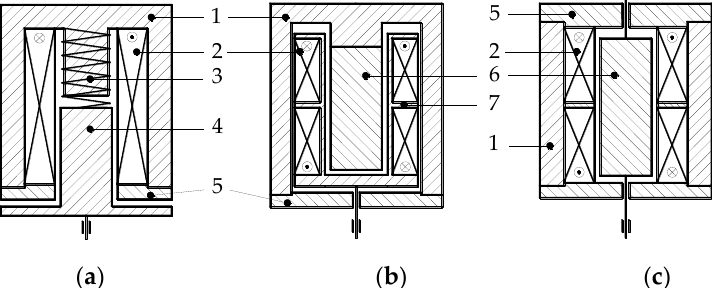
Figure 2. Basic configurations of electromagnetic actuators. ( a ) Solenoid actuator (SA); ( b ) moving coil actuator (MCA), and ( c ) moving magnet actuator (MMA). 1. Iron shell/frame; 2. coil; 3. spring; 4. plunger; 5. flange; 6. magnet; and 7. coil holder.